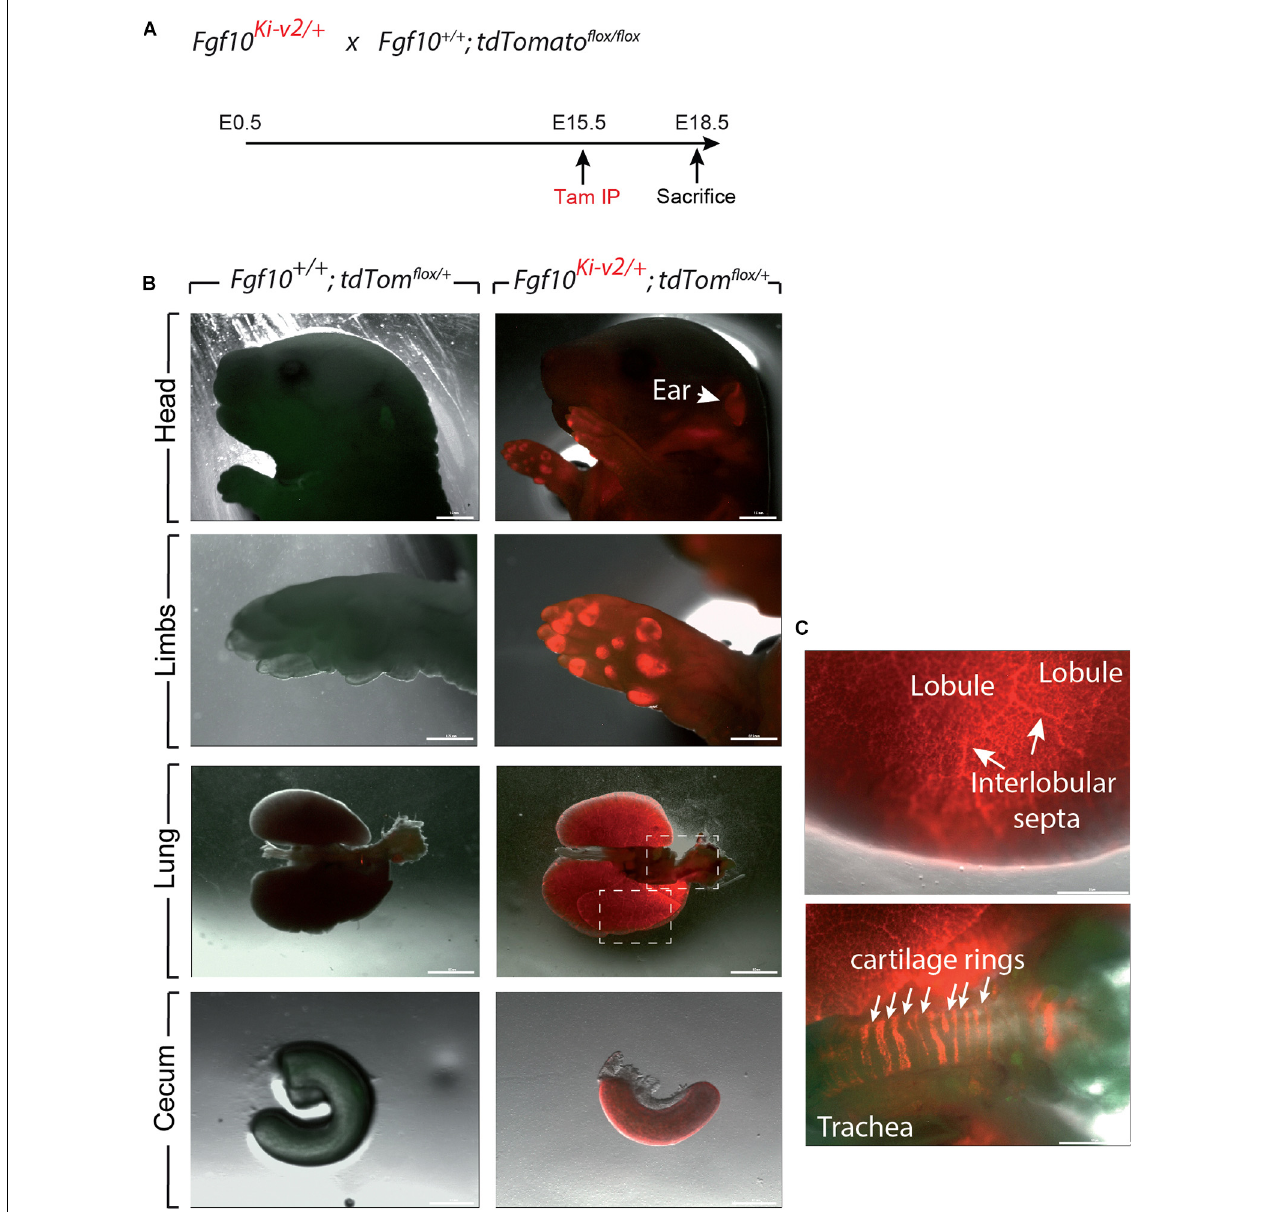
FIGURE 4 | Validation of the labeling of FGF10 Pos cells at E15.5. (A) Fgf10 Ki - v 2 / + were crossed with Fgf10 + / + ; tdTom flox / flox mice. Pregnant females received a single IP injection of tamoxifen when the embryos were at E15.5 and sacrificed at E18.5. (B) Head, limbs, lung and cecum of Fgf10 + / + ; tdTom flox / + and Fgf10 Ki - v 2 / + ; tdTom flox / + embryos are shown. Note the expression in the external ear (arrow). (C) Higher magnification of lung and trachea showing enriched tdTomato expression in the interlobular septa and the presence of tdTomato expression between the cartilage rings, respectively. Scale bar in (B) : head: 1.5 mm, Limb: 0.75 mm, Lung: 0.5 mm, Cecum: 0.1 mm. Scale bar in (C) : Lung 25 µ m, Trachea 125 µ m.